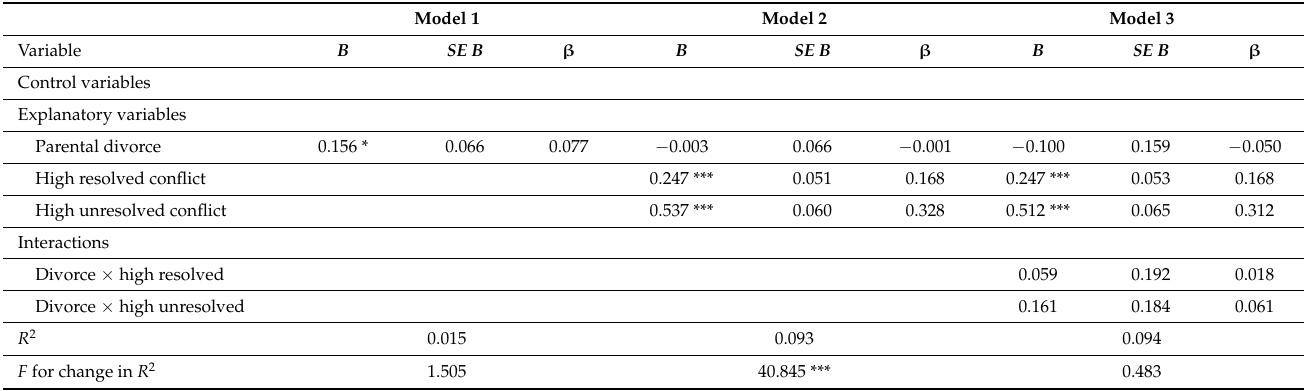
Table 5. Summary of the hierarchical multiple regressions for the variables predicting alienation in mother-child relation- ships.